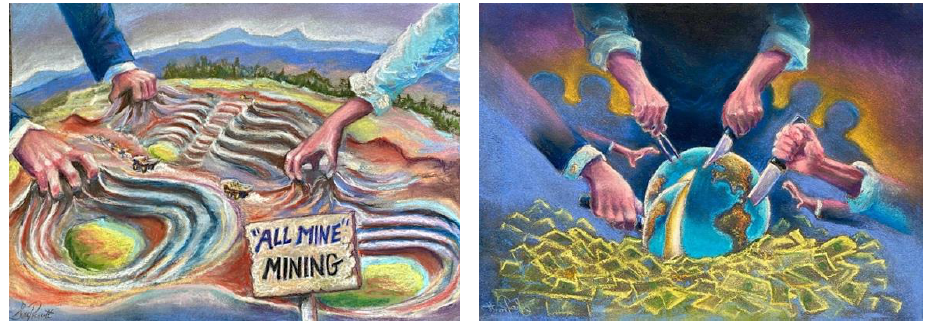
Figure 5. Mindsets of the Anthropocene: We share the reflections by author J.M.G. in response to this